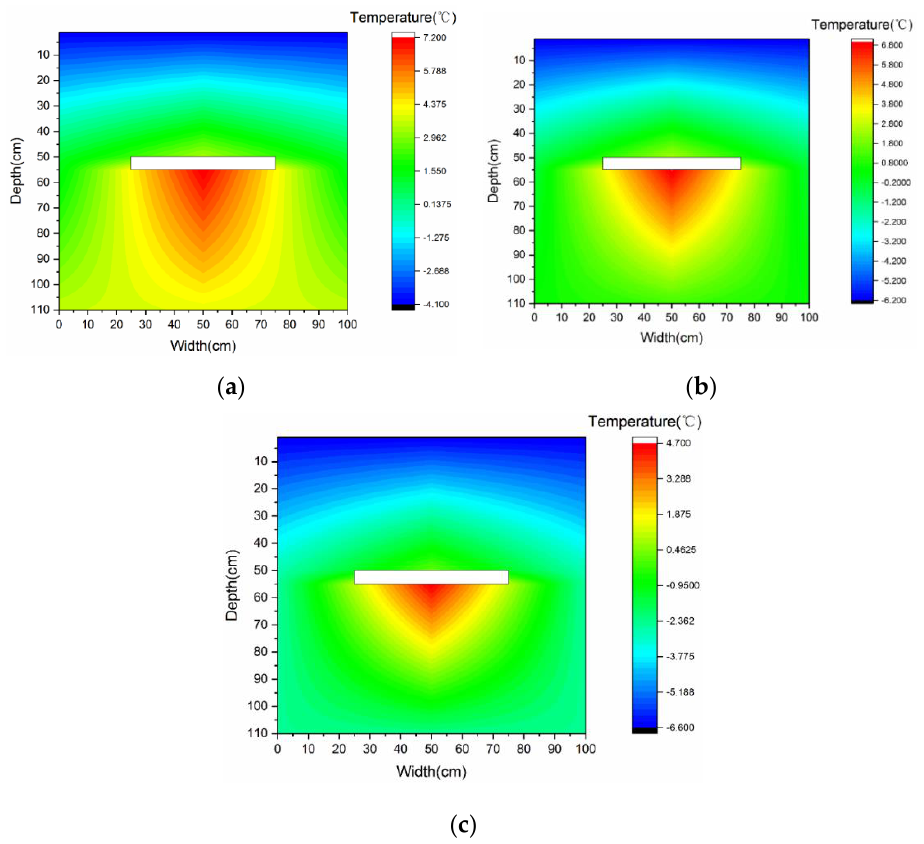
Figure 7. Schematic diagrams of temperature distribution inside subgrade at different stages: ( a ) initially freezing; ( b ) deeply freezing; ( c ) fully freezing.